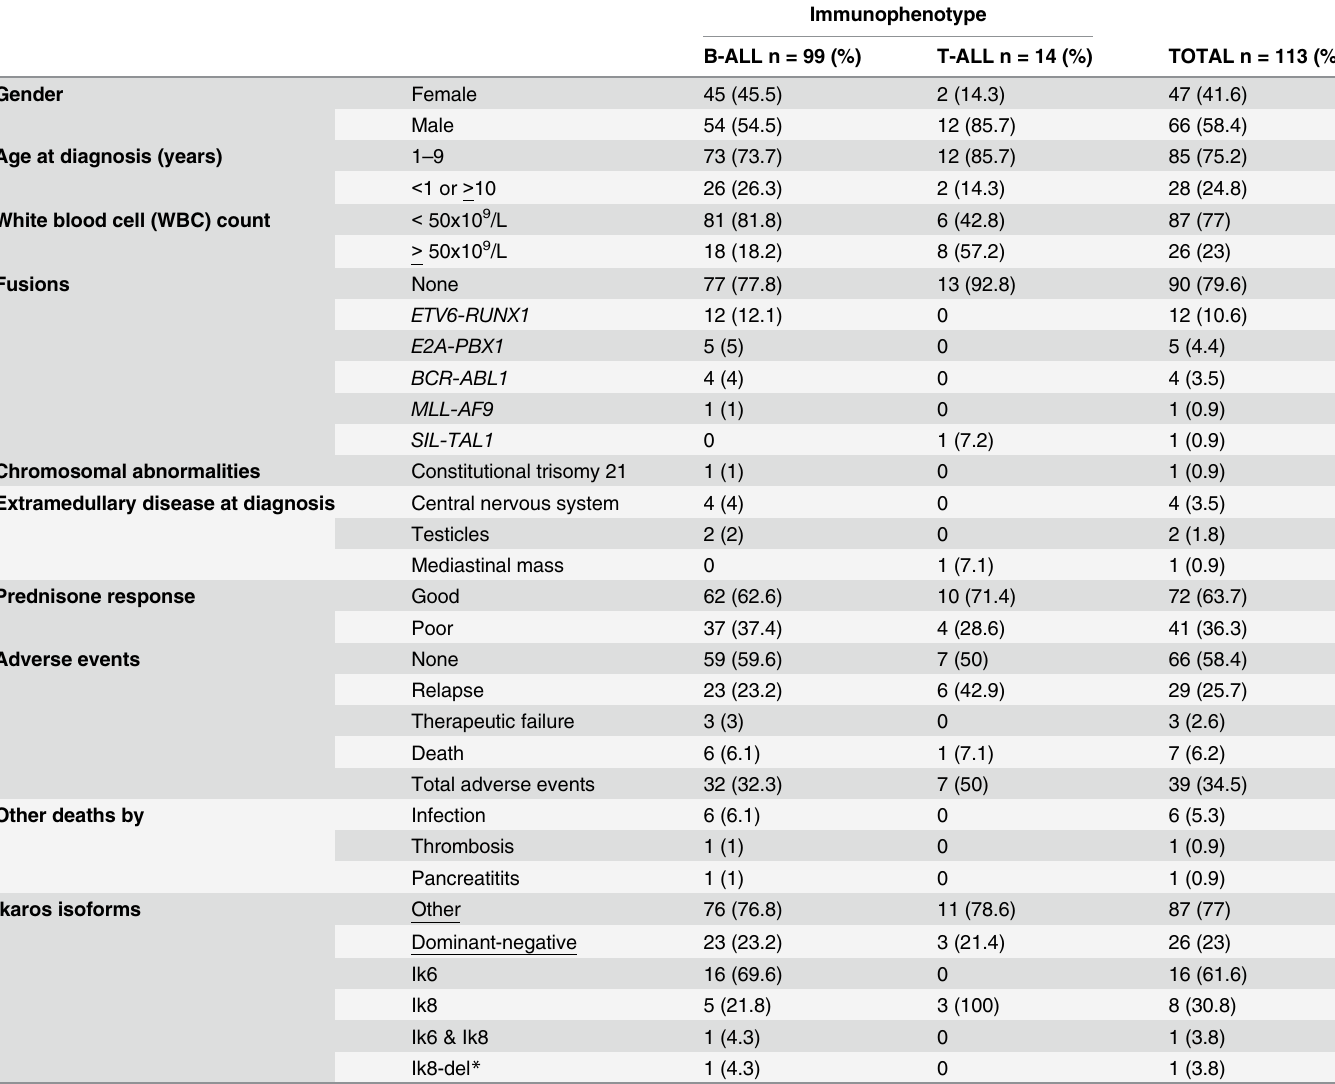
Table 1. Characteristics of 113 pediatric patients with